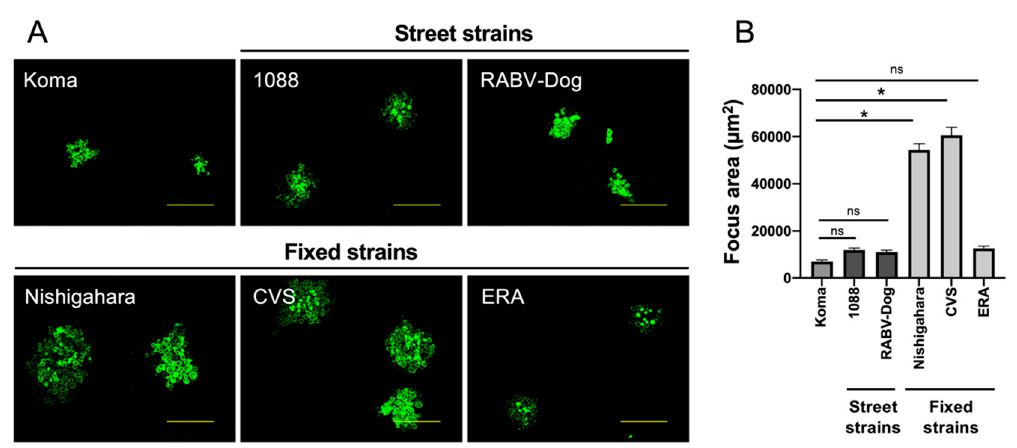
Figure 6. Focus formation by Koma and representative street and fixed strains in mouse neuroblastoma C1300 (NA) cells. ( A ) At 3 days after inoculation of NA cells with each virus strain at an MOI of 0.0002, the cells were fixed and immunostained with an anti-RABV N protein antibody. The scale bars correspond to 200 µ m. ( B ) Fifty foci of each strain were randomly selected to quantify their areas by Image J software. Each column represents the average area ( ± standard errors of the means). *, Significant di ff erences vs. the Koma strain at a p value of < 0.05; ns, not significant ( p ≥ 0.05) .